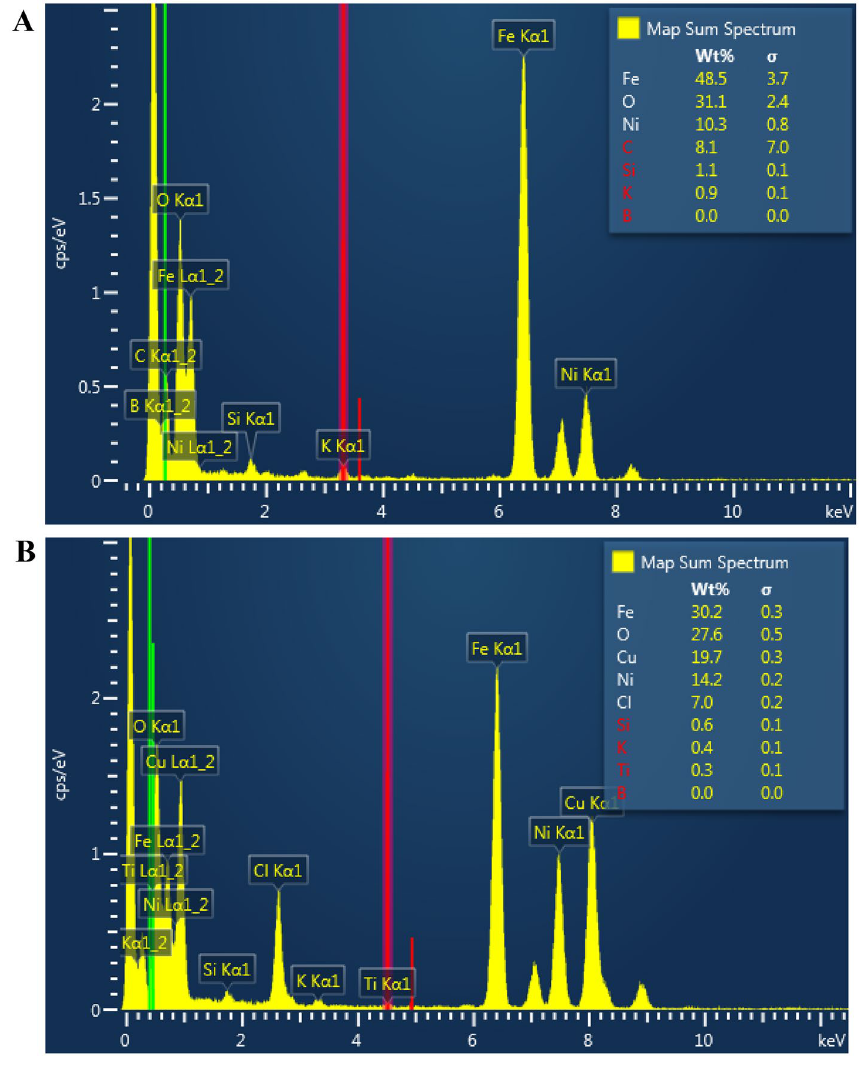
Figure 6. EDS spectra of Ps@Tet@Fe 3 O 4 ( A ) and Ps@Tet-Cu(II)@Fe 3 O 4 ( B